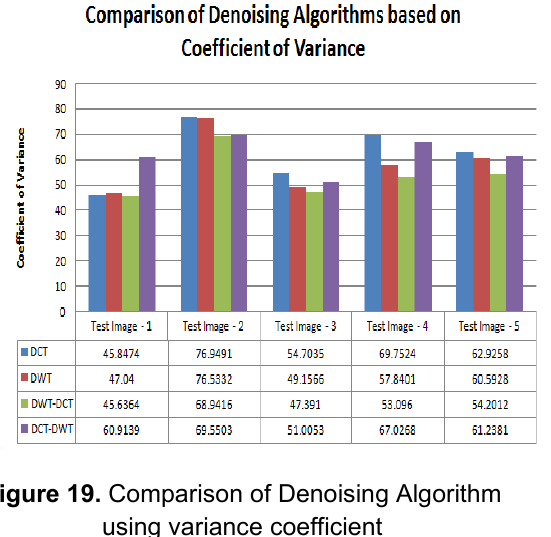
Figure 19. Comparison of Denoising Algorithm using variance coefficient The maximum Structural Similarity Index of Hybrid Algorithm is given in Figure 20 .